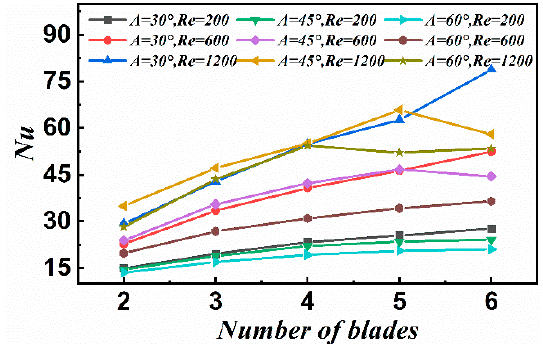
Figure 6. Variations of Nu with blade number at P = 3 mm.